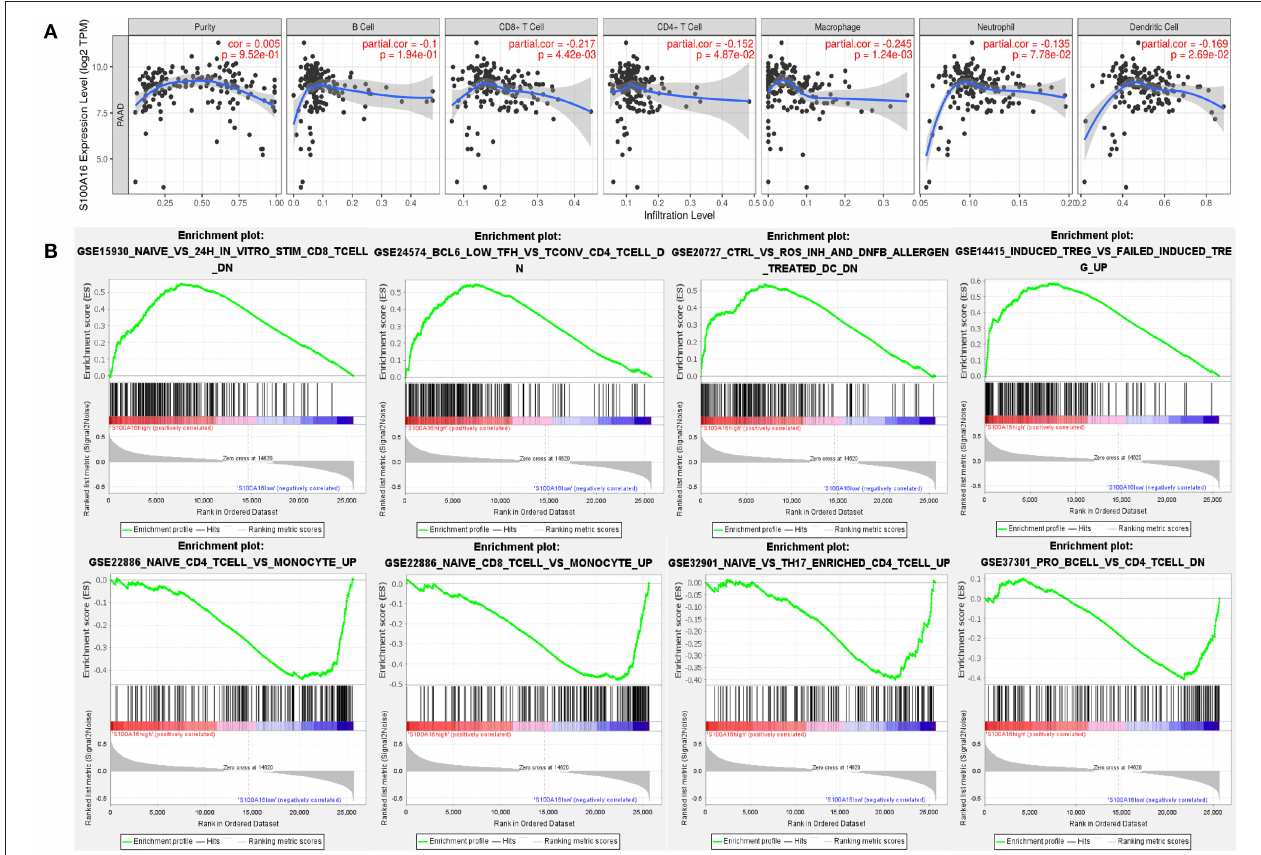
FIGURE 13 | Correlation analysis between the expression level of S100A16 and immune infiltration. (A) GSEA analysis showed that naive BCL6, low ctrl induced treg were differentially enriched in the high expression S100A16 phenotype. Naive CD4T cell, naive CD8T cell, and naive, pro B cell were differentially enriched in the low expression S100A16 phenotype (B)